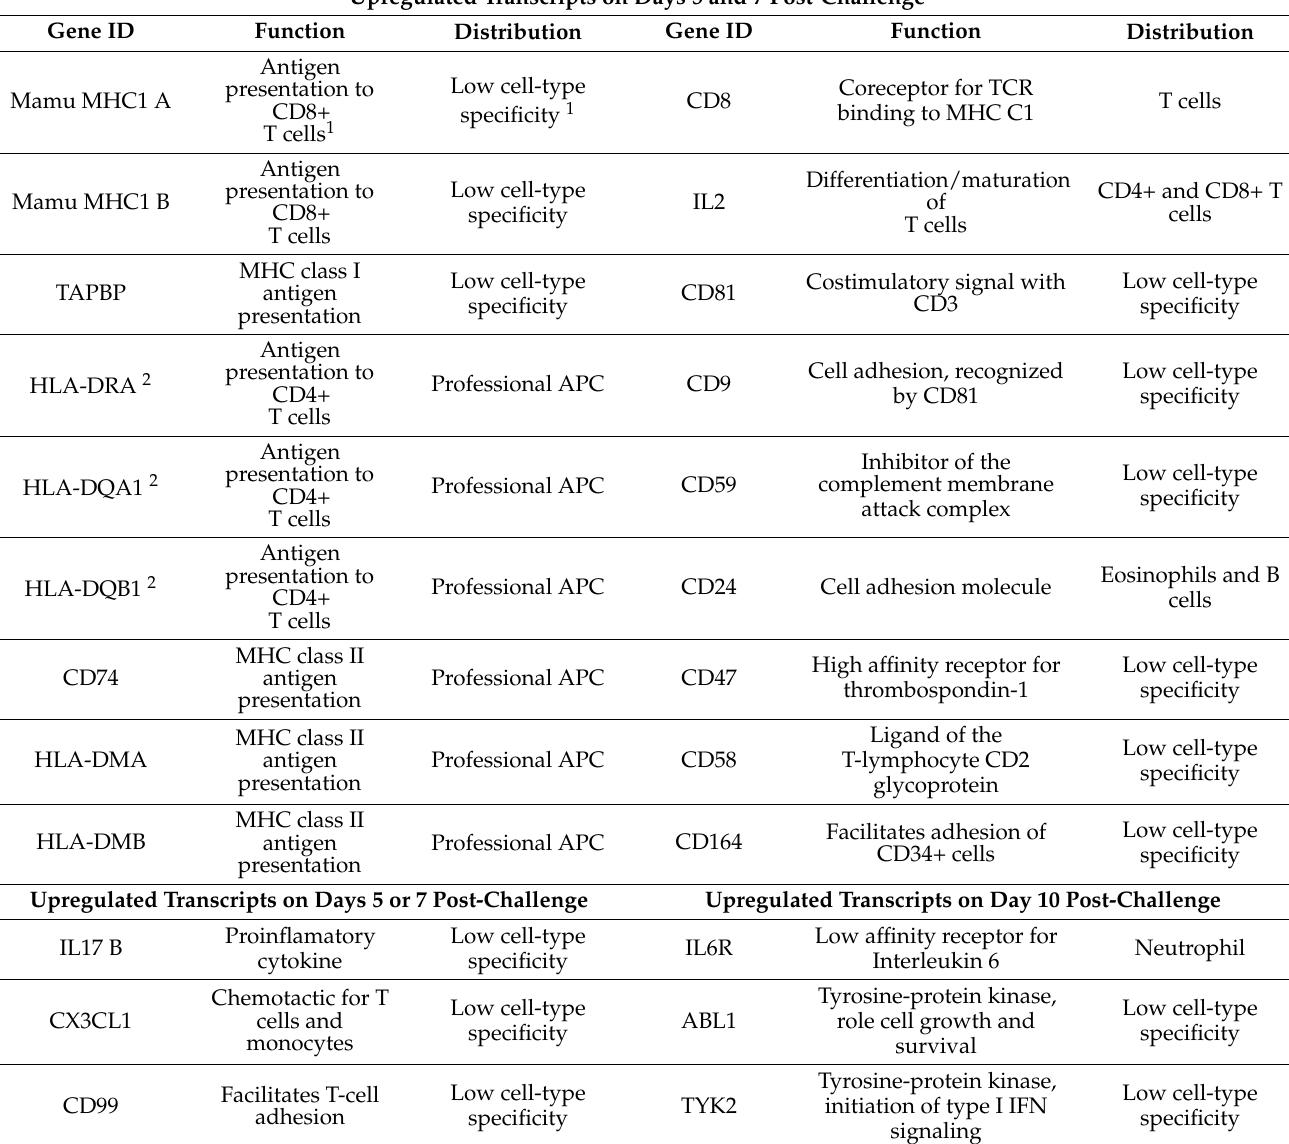
Table 1. Differentially regulated genes in BAL cells obtained from SARS-CoV-2-challenged vaccinated versus con- trol